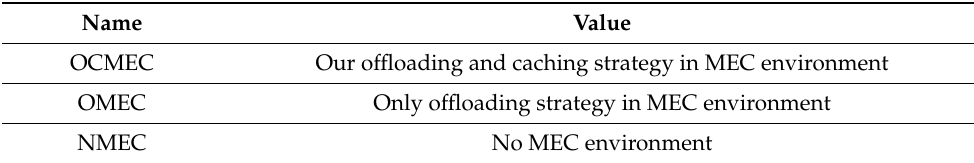
Table 2. The three schemes in MATLAB simulation.